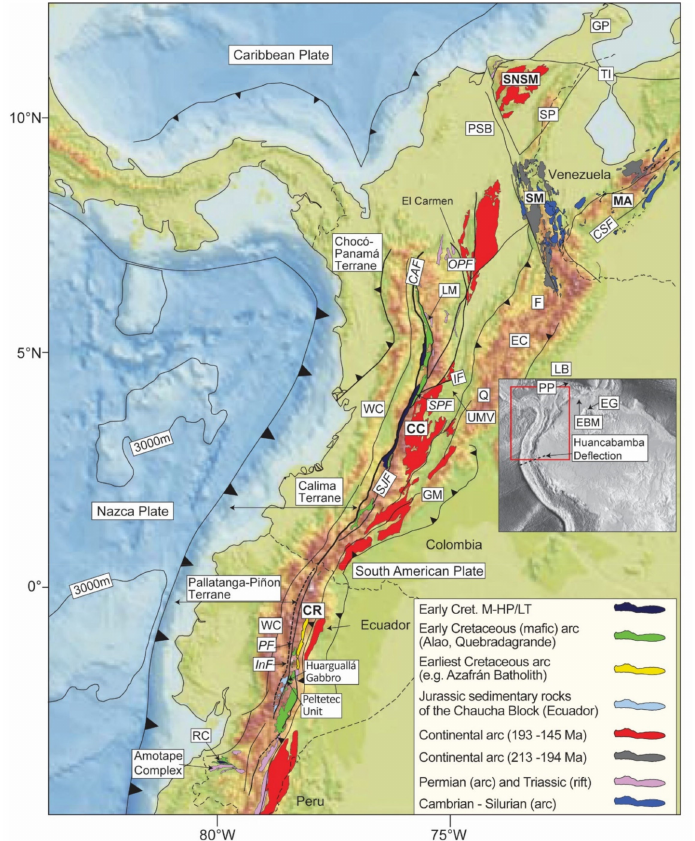
Figure 1. Digital elevation model for northwestern South America showing the cordilleras, terranes, main faults and the exposure of Cambrian–Cretaceous magmatic rocks in Venezuela, Colombia and Ecuador and Colombia. Faults: CAF: Cauca-Almaguer Fault, CSF: Caparo-Soledad Fault, IF: Ibagu